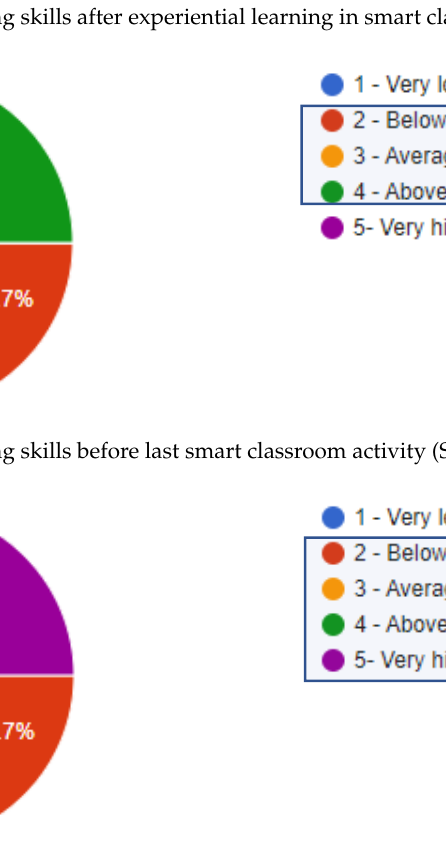
Figure 11. Students’ creating skills after experiential learning in smart classroom (Subject 1).